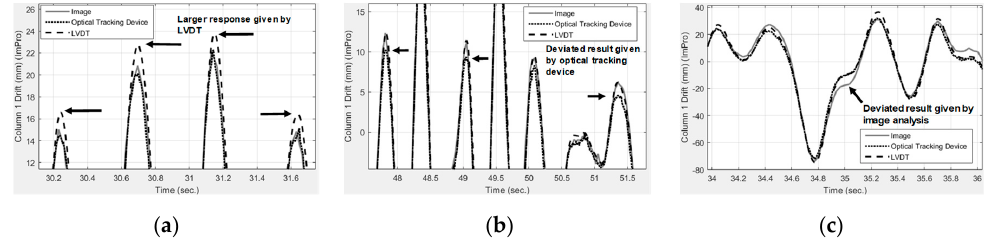
Figure 18. Responses where one device deviated from the others. The image analysis reaches the same accuracy when comparing with the optical tracking and LVDT devices. ( a ) Peaks where LVDT results were higher than others. ( b ) Peaks where optical tracking results were lower than others. ( c ) Duration where image analysis were different from others.